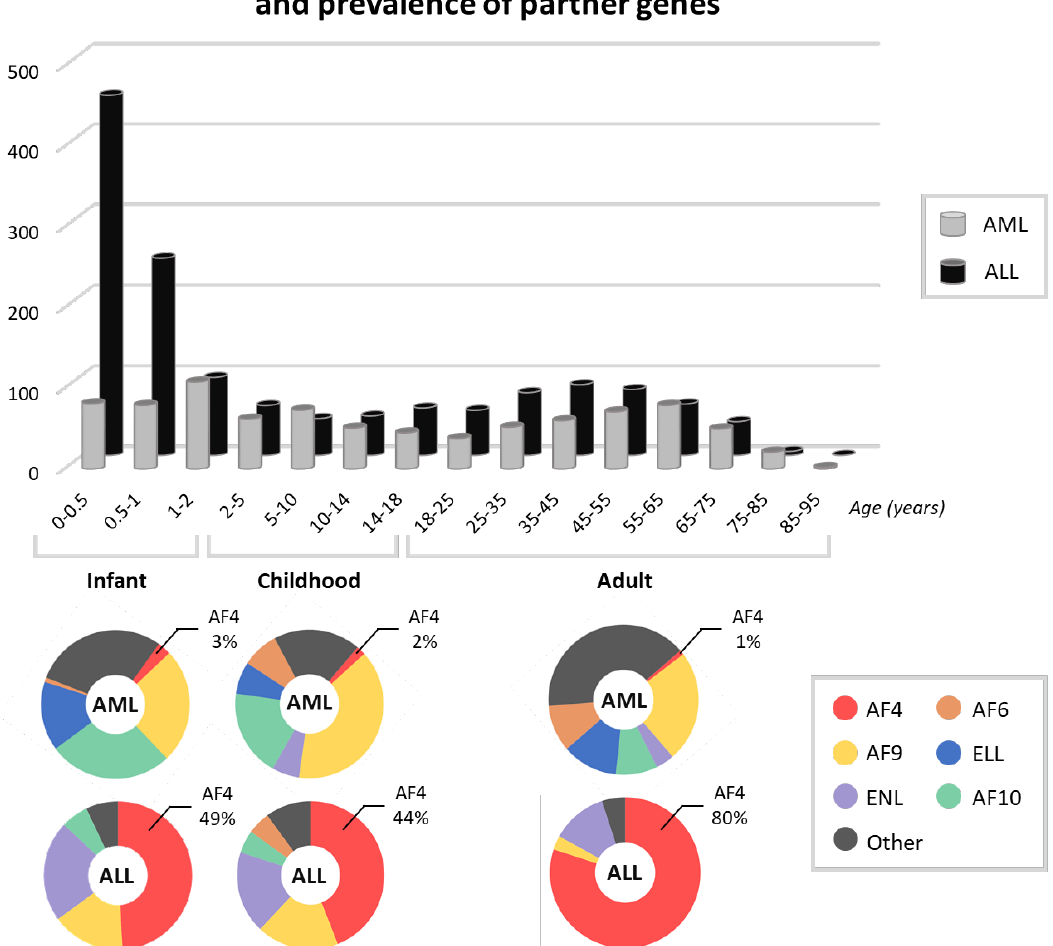
Figure 1. The age distribution of 2345 patients with MLL rearrangements ( MLL -r) by diagnosis (acute myeloid leukemia (AML) or acute lymphoblastic leukemia (ALL)), as analyzed by Meyer et al. [17].